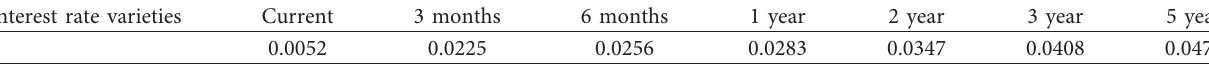
Table 3: Average interest rate of time deposit of each term.